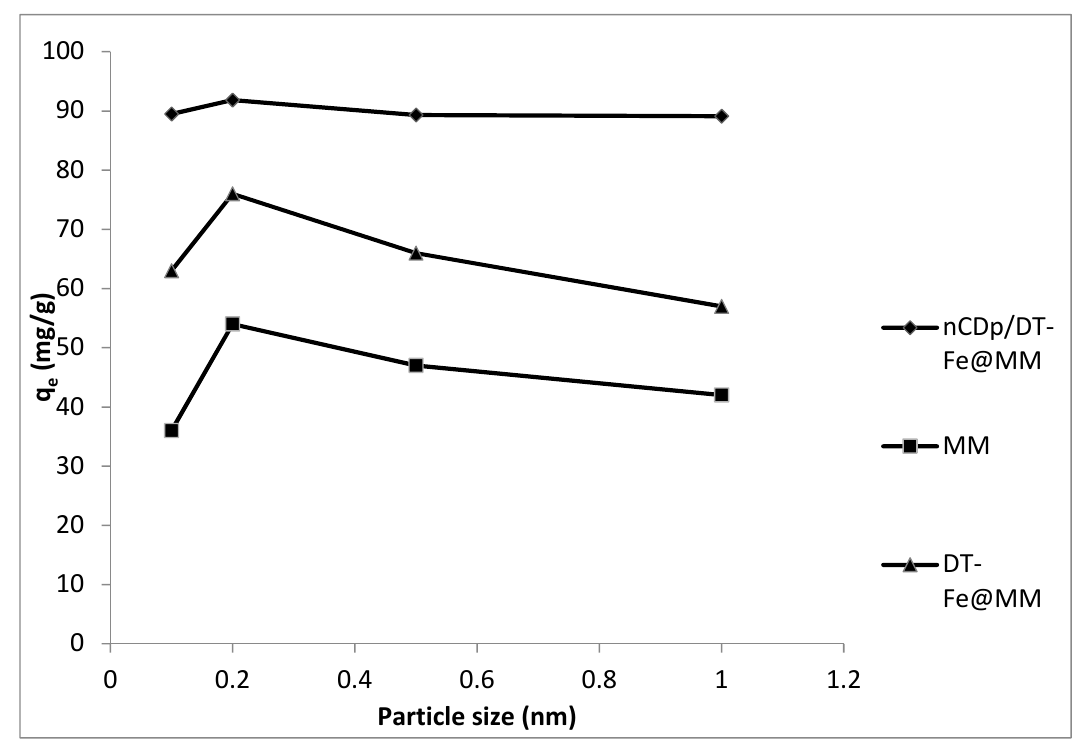
Figure 12. Effect of pH on the removal of BPA. (Adsorption conditions: C o 50 mg/L; T = 30 °C; dosage = 0.02 g/L; t = 120 min).